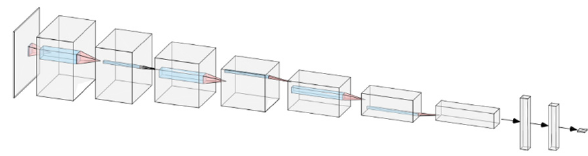
Figure 6. Basic CNN structure diagram.